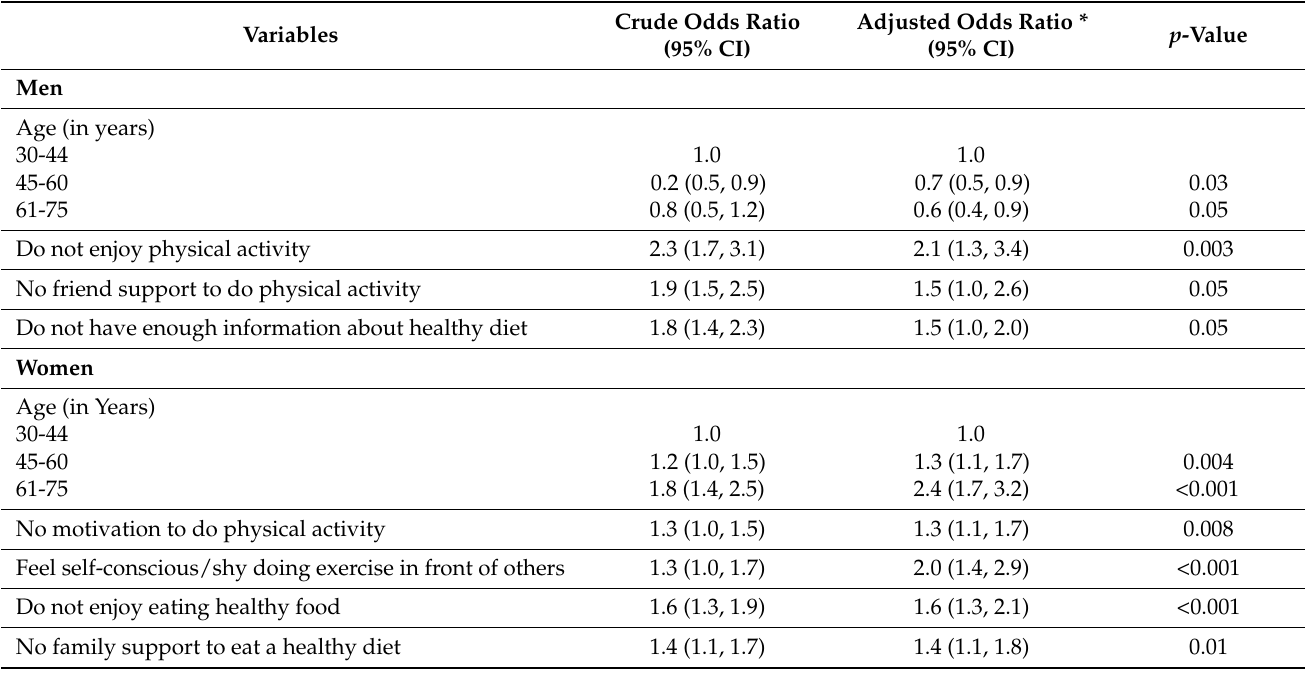
Table 4. Multivariate logistic regression showing adjusted odds ratio and 95% CI for factors associated with an unhealthy lifestyle among Saudi men and women in Riyadh, Saudi